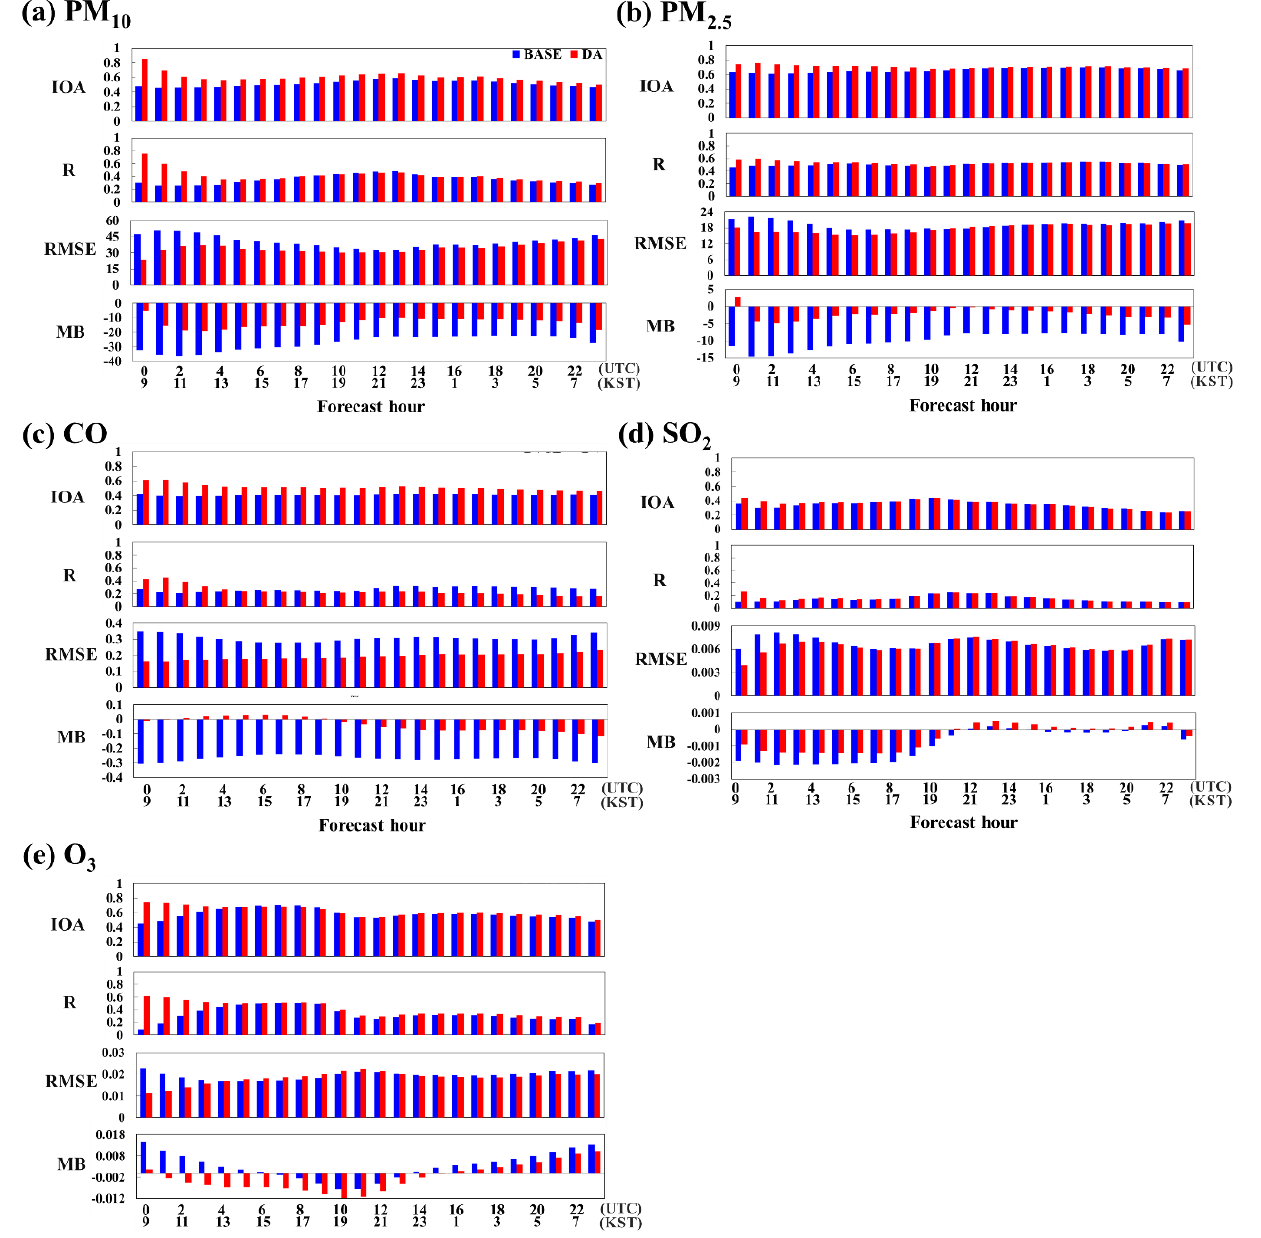
Figure 11. Time-series plots of four performance metrics (IOA, R , RMSE and MB) for (a) PM 10 , (b) PM 2 . 5 , (c) CO, (d) SO 2 and (e) O 3 forecasts. The DA was conducted at 00:00UTC. The units of RMSE and MB are micrograms per cubic meter and parts per million by volume for PM concentrations and for gaseous species, respectively. The definitions of the four performance metrics are shown in Appendix